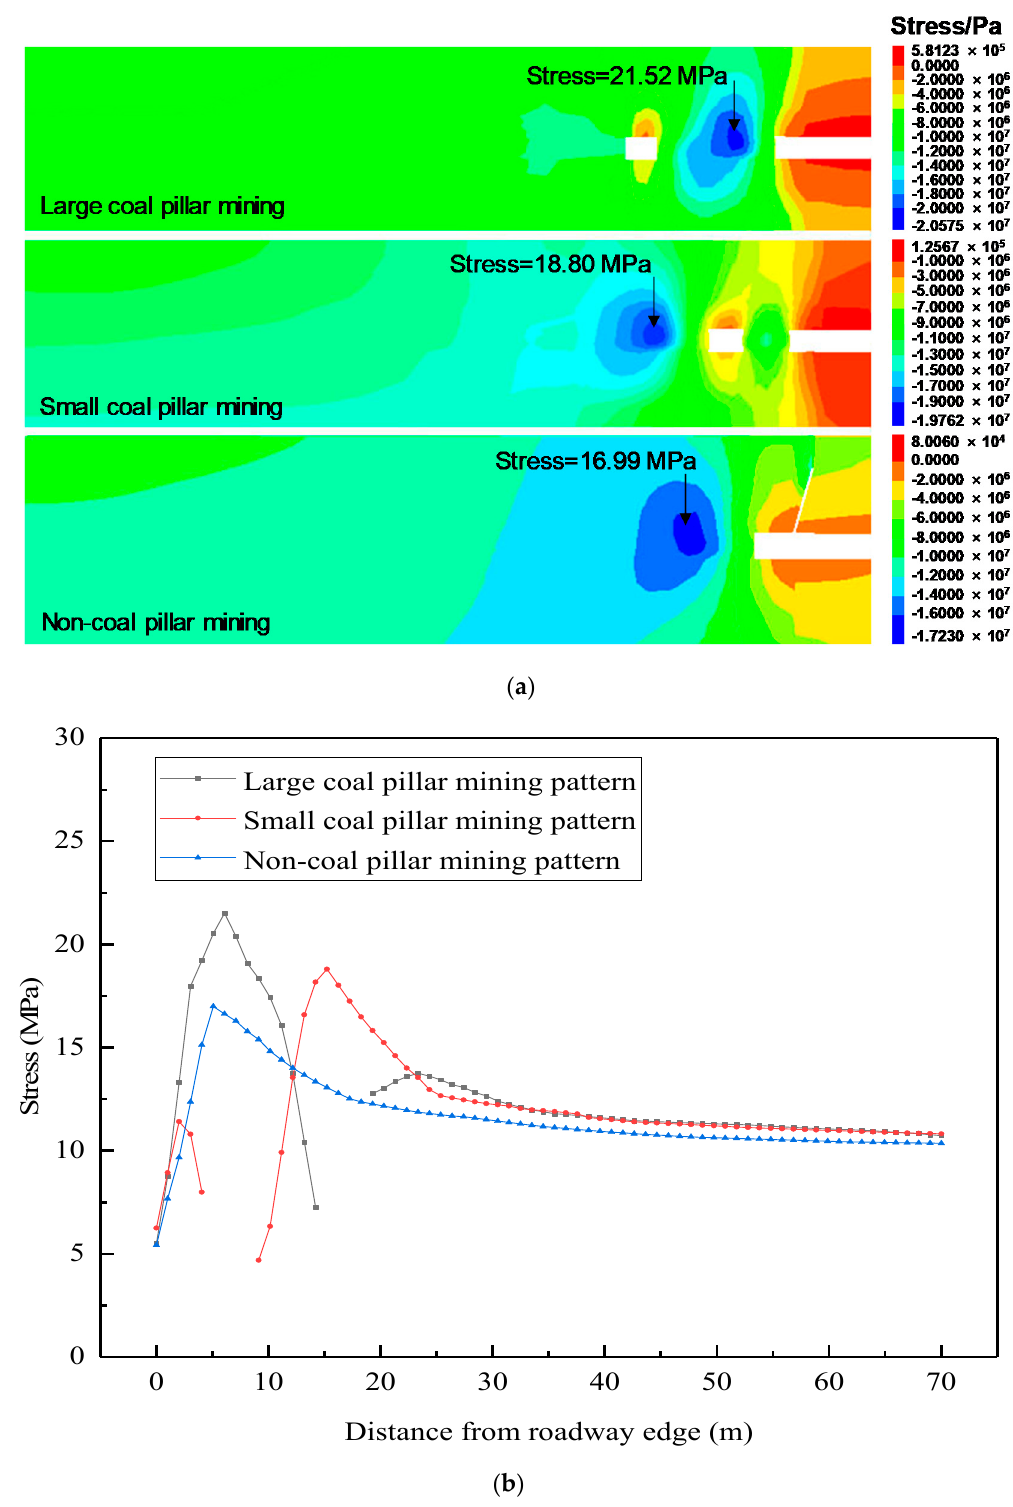
Figure 13. Vertical stress nephogram and stress distribution curve at monitoring line 10 in lateral direction of working face. ( a ) Vertical stress nephogram; ( b ) Vertical stress distribution curve.